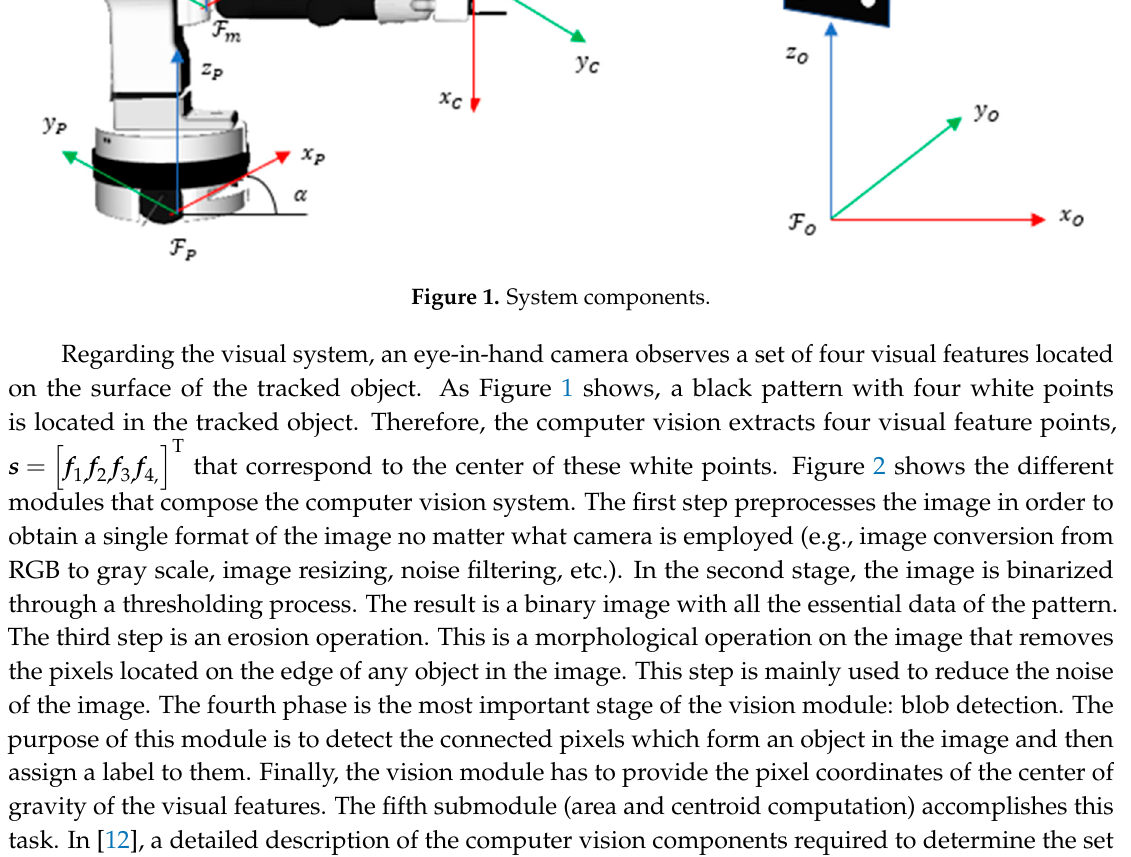
Figure 2. Computer vision components.